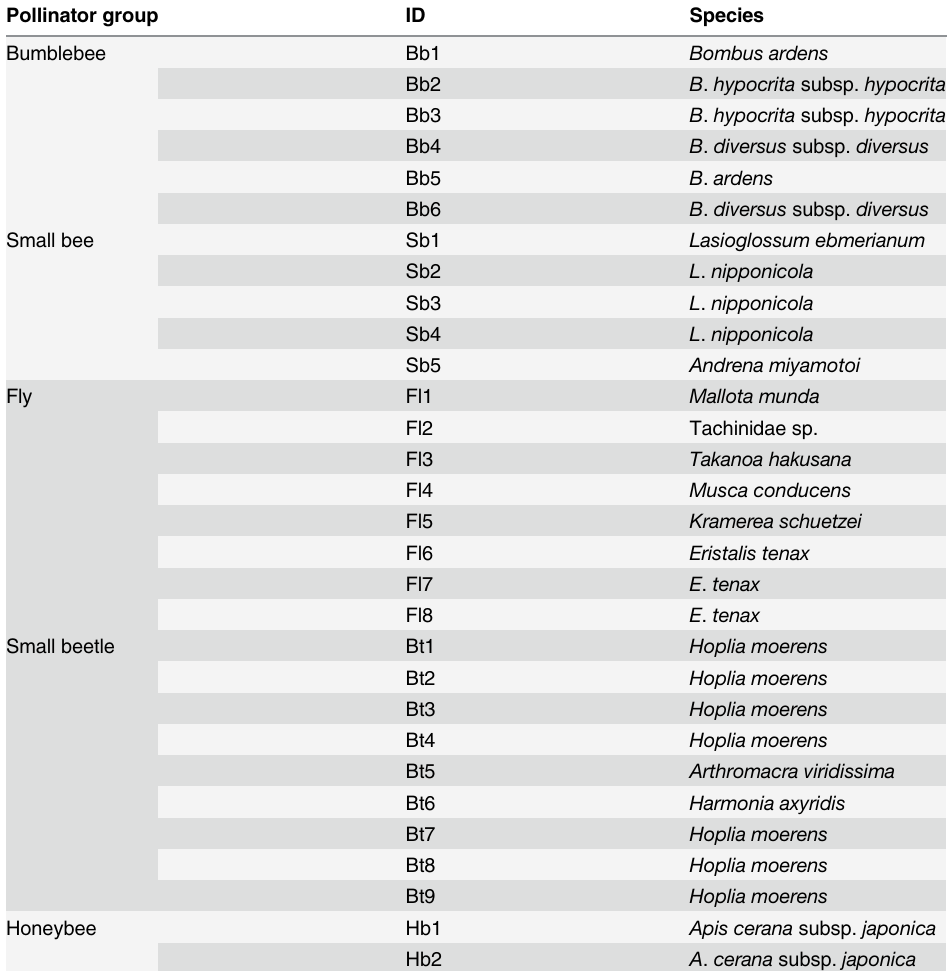
Table 1. List of insect pollinators. Pollinator